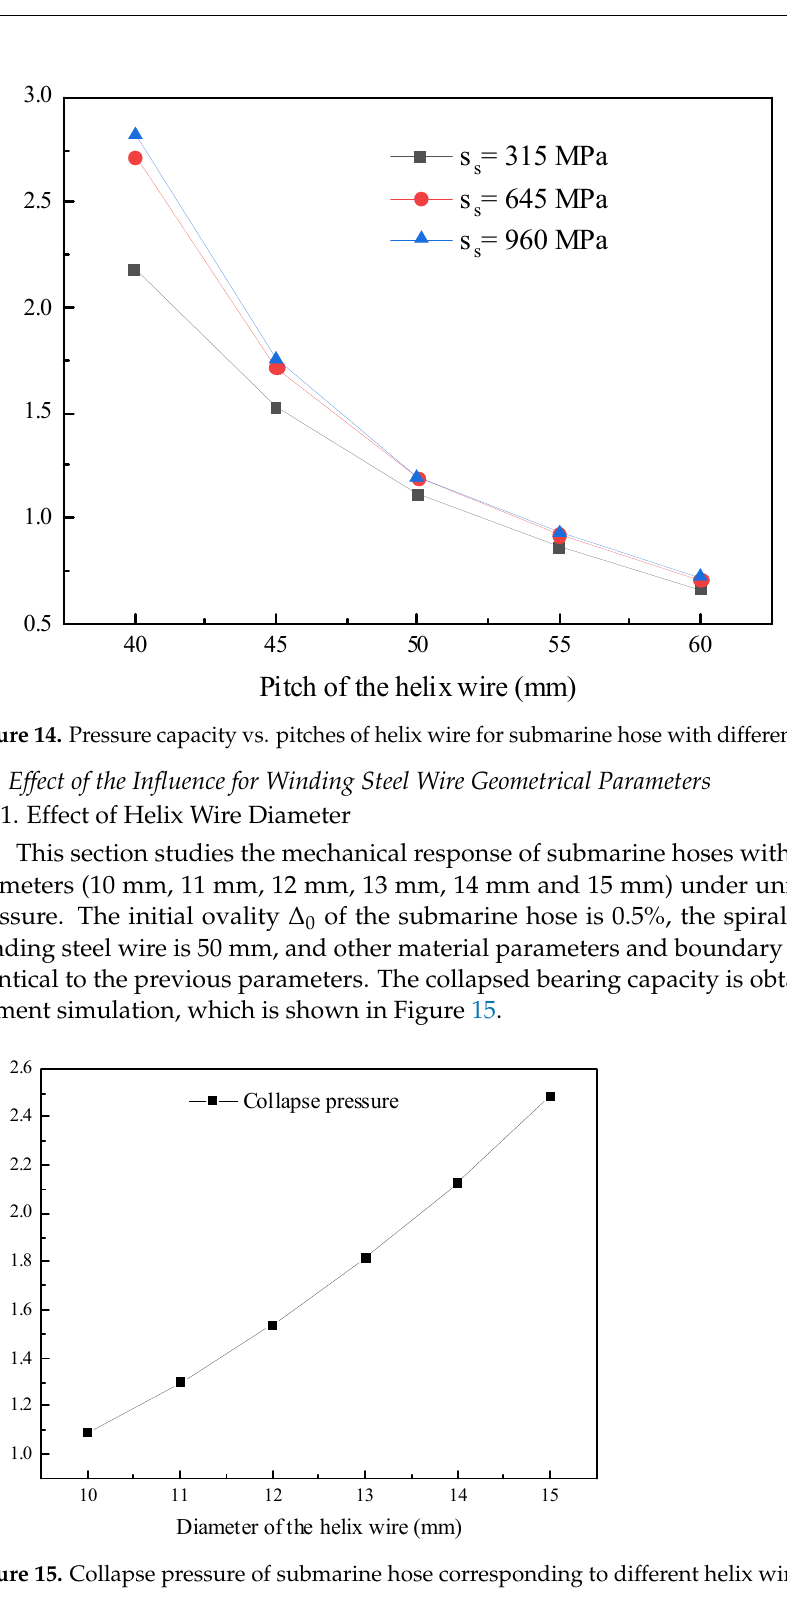
Figure 15. Collapse pressure of submarine hose corresponding to different helix wire diameters. It can be seen from Figure 15 that increasing the diameter of the steel helix wire is of great help for improving the compressive performance of the submarine hose. When the